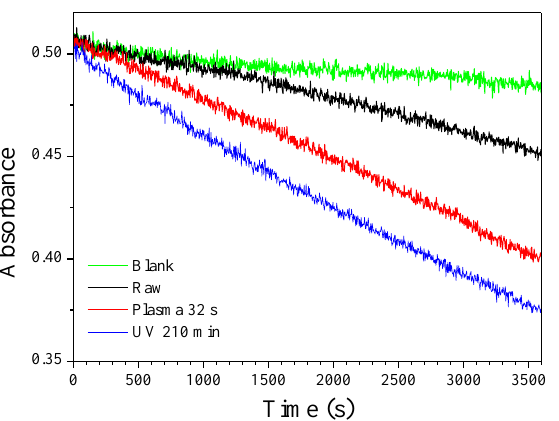
Figure 8. Degradation of 2 mg/L aqueous solution of AO7 with immobilized TSC layers treated by plasma and UV-irradiation.